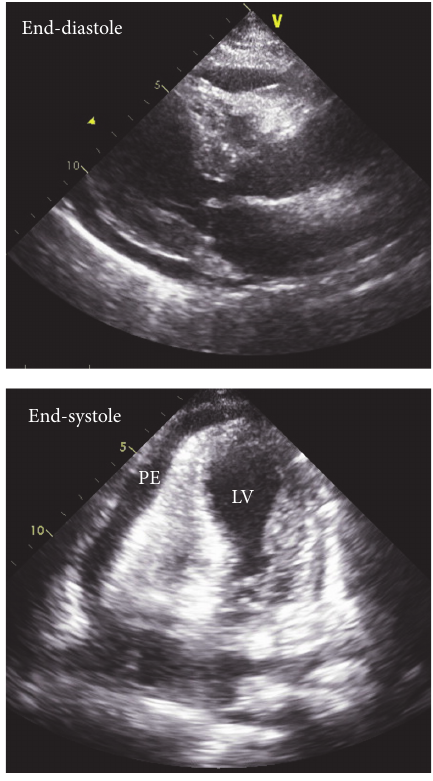
Figure 4: Transthoracic echocardiography showed small amounts of pericardial effusion, apical ballooning, and right ventricular collapse at